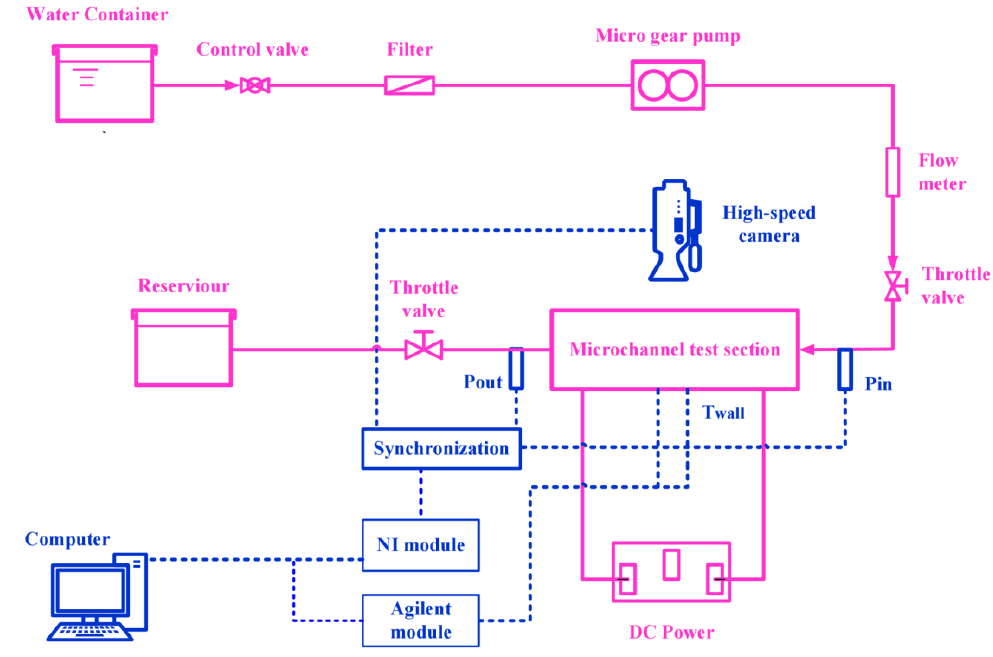
Figure 1. Flow diagram and measurement system.